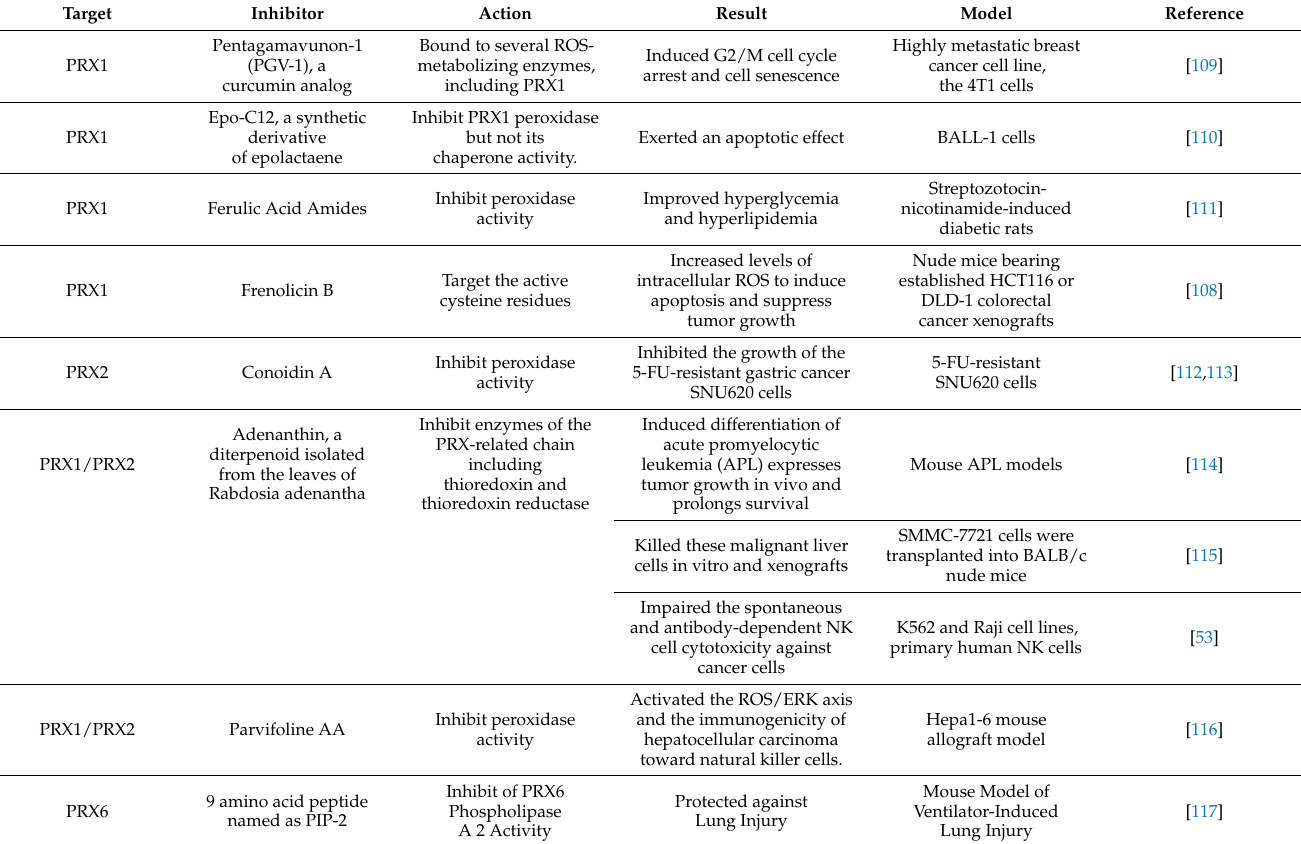
Table 2. List of peroxiredoxin